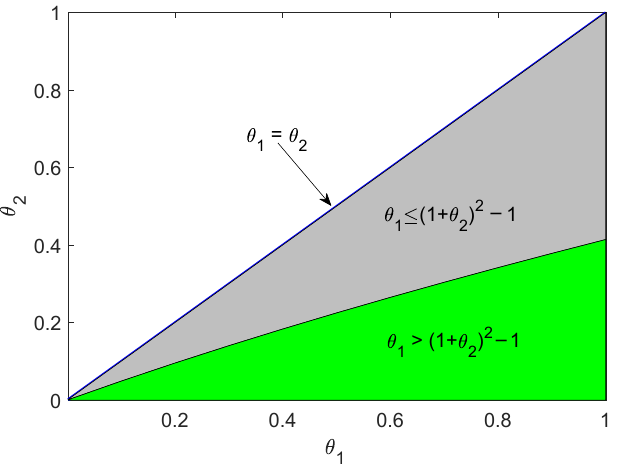
Figure 3. Phase diagram of admissible relative safety loading parameters ( θ 1 , θ 2 ). Note that the assumptions of Theorem 1 correspond to the green area given by θ 1 > ( 1 + θ 2 ) 2 − 1. Note that in the region of θ 1 ≤ ( 1 + θ 2 ) 2 − 1, which is depicted in grey, our approach is not applicable; then, the first case of Theorem 2 in Avram et al. (2008a) can be